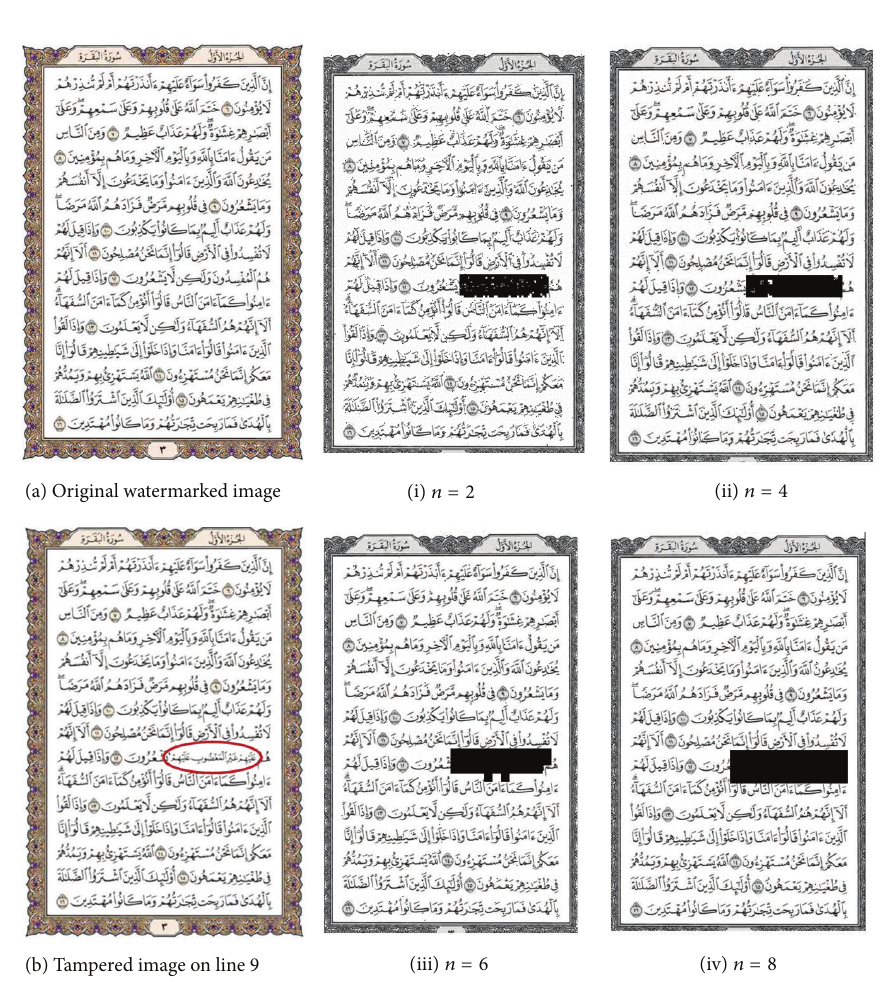
Figure 14: Tamper detection on collage attack